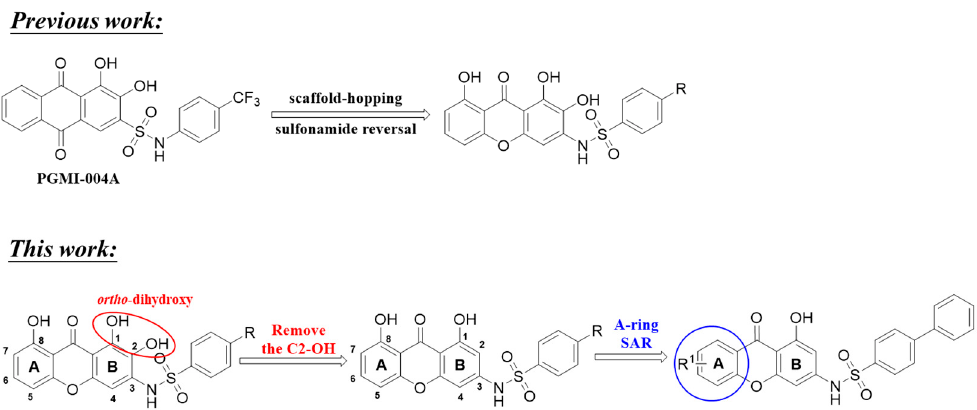
Figure 2. The optimization process of PGMI-004A.